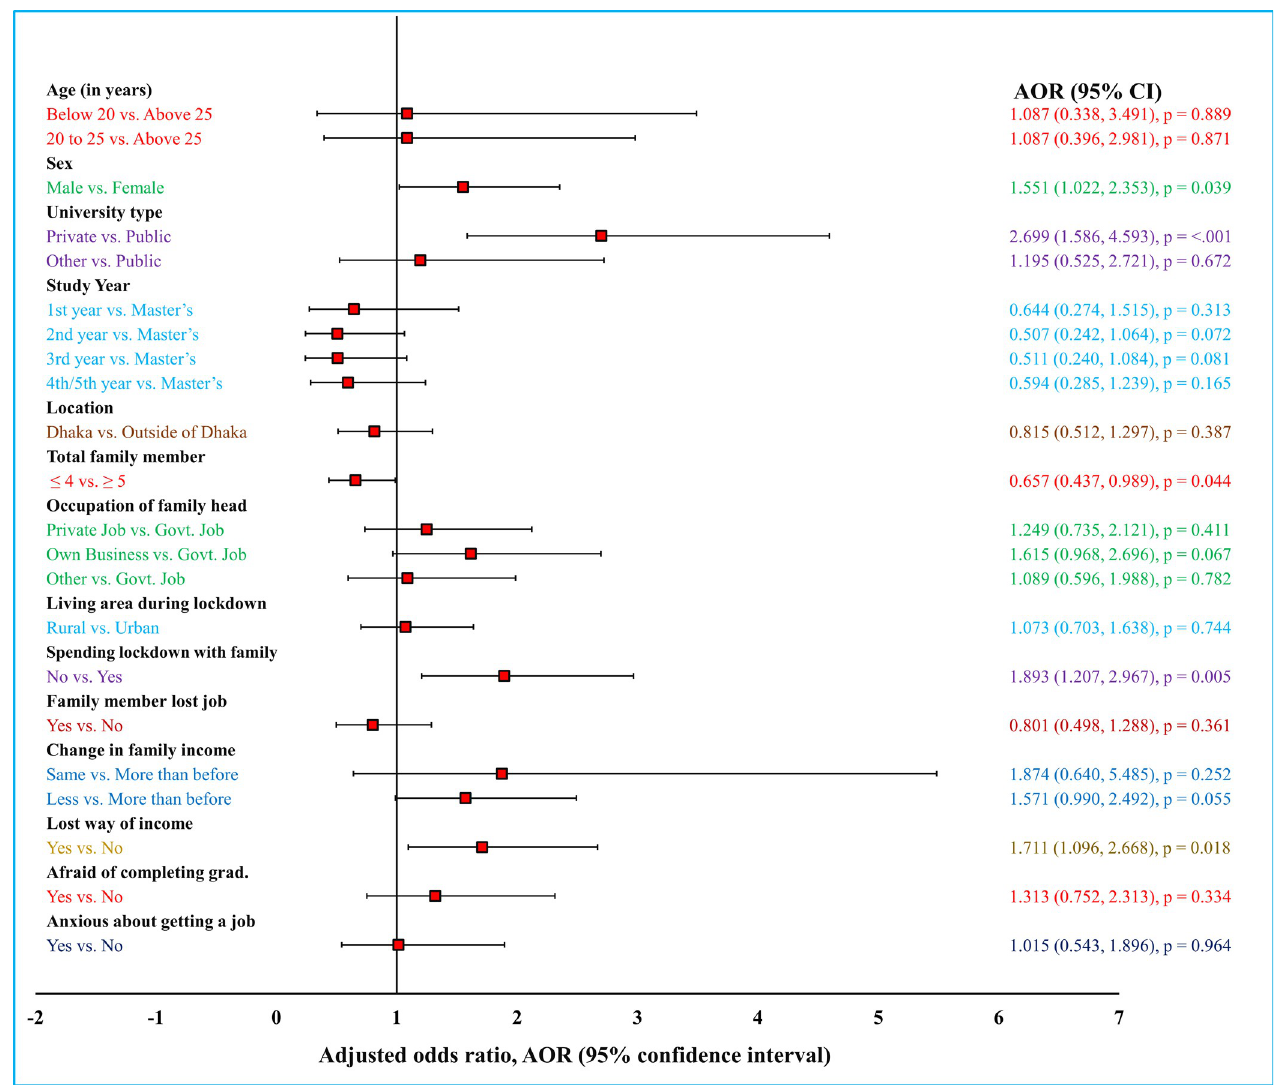
Fig 2. Forest plot representation for multivariate logistic regression analysis of anxiety among the university students amid the second wave of the COVID-19 outbreak in